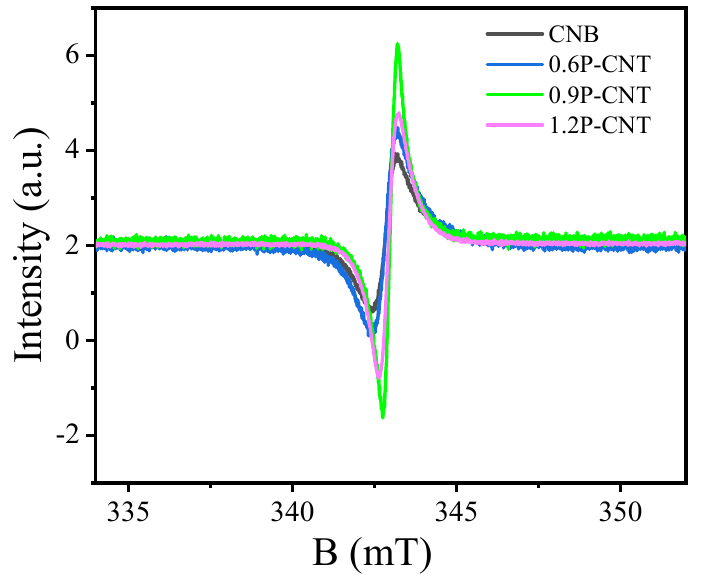
Figure 12. Room temperature EPR signals for the CNB, 0.6P-CNT, 0.9P-CNT, and 1.2P-CNT samples.